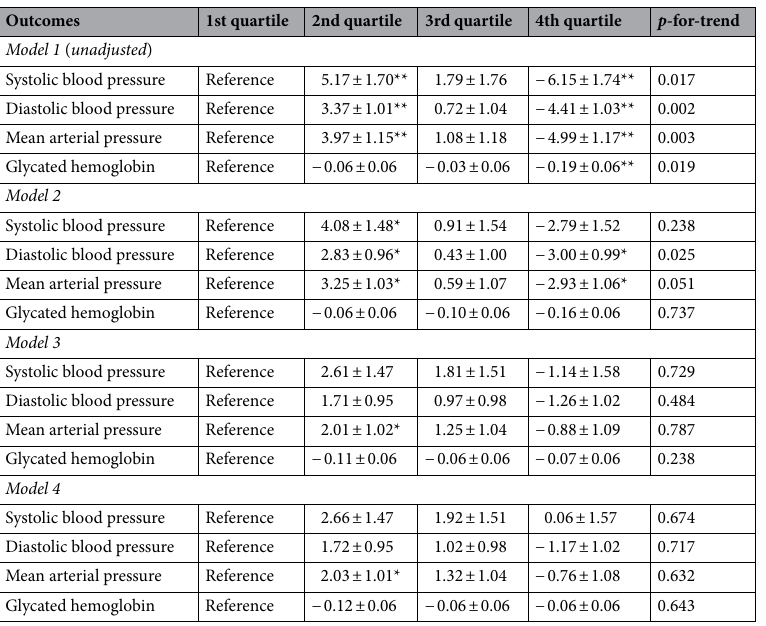
Table 3. Linear regression models of the association of egg consumption with blood pressure parameters and glycated hemoglobin. Values indicate the coefficient ± standard error obtained through linear regression models. Model 1: unadjusted. Model 2: adjusted for age (continuous, years), sex (male, female) and education level (primary or secondary studies, university studies). Model 3: Model 2 adjusted for body mass index (continuous, Kg/m 2 ), total energy intake (continuous, kcal/day) and adherence to the Mediterranean Diet (continuous, MEDAS score). Model 4: Model 3 adjusted for smoking status (nonsmoker or former smoker, current smoker), alcohol intake (nondrinker, current alcohol drinker) and moderate-to-vigorous physical activity (continuous, minutes/week). * p < 0.050, ** p <